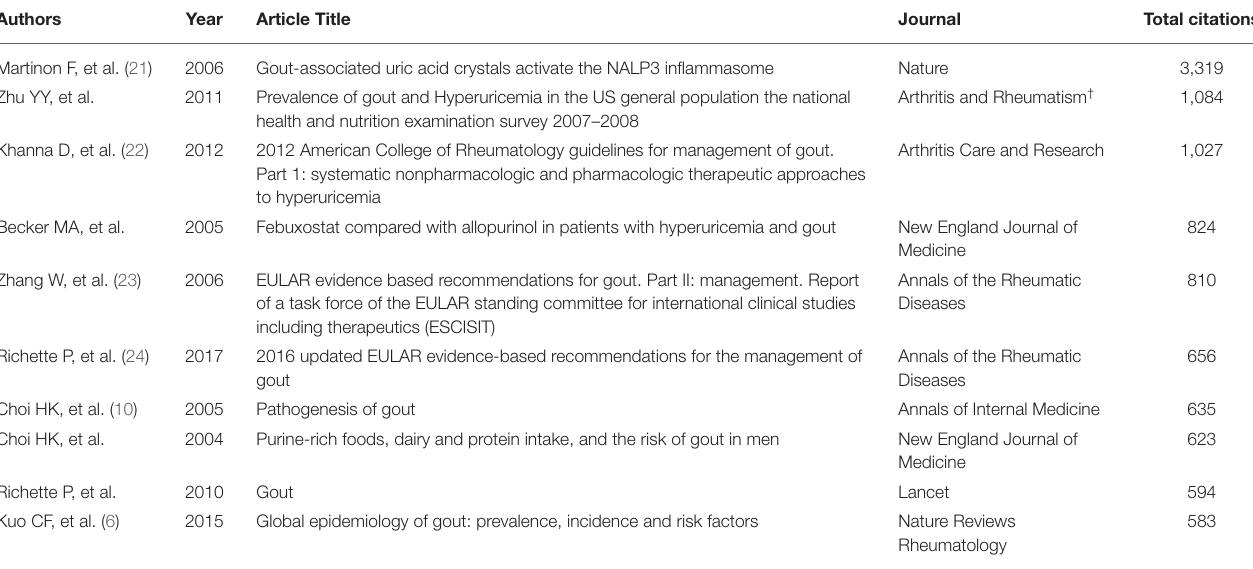
TABLE 4 | Top 10 high-cited articles on gout research.